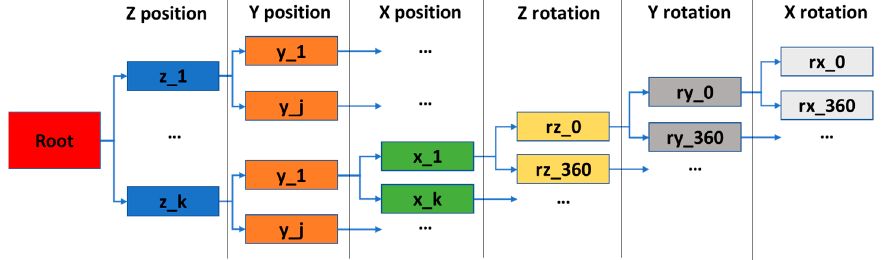
Figure 4. EIM—alternatives generation—decision tree.